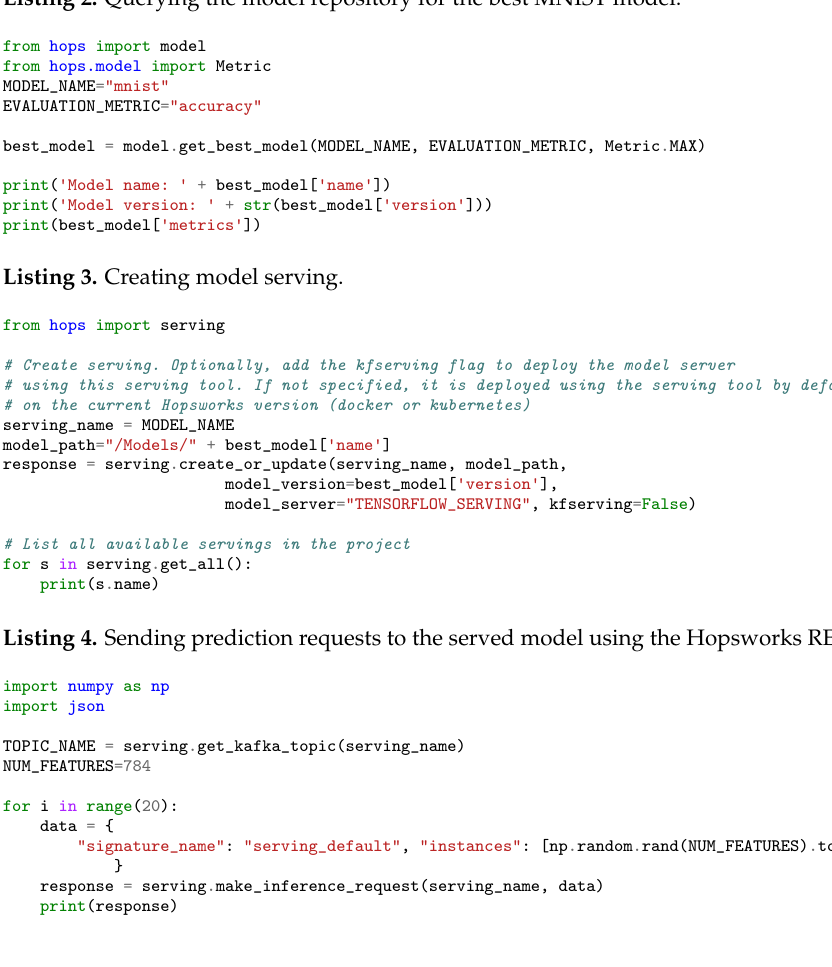
Figure 7. The architecture for model monitoring and serving in the Hopsworks platform [11]. Listing 2. Querying the model repository for the best MNIST